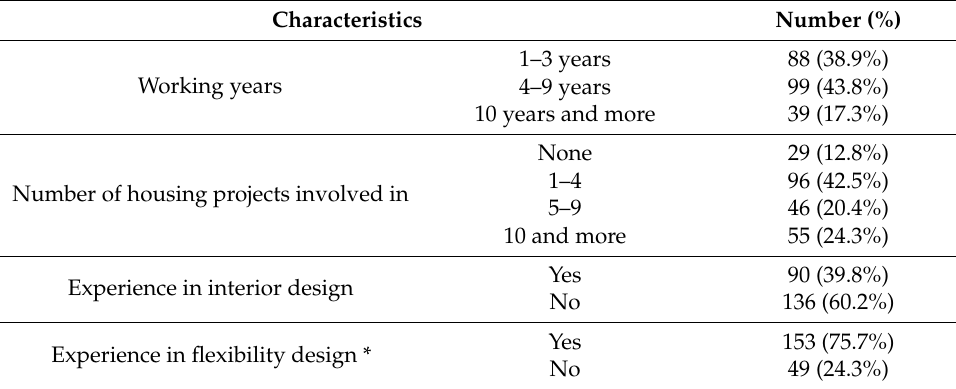
Table 5. Characteristics of architect